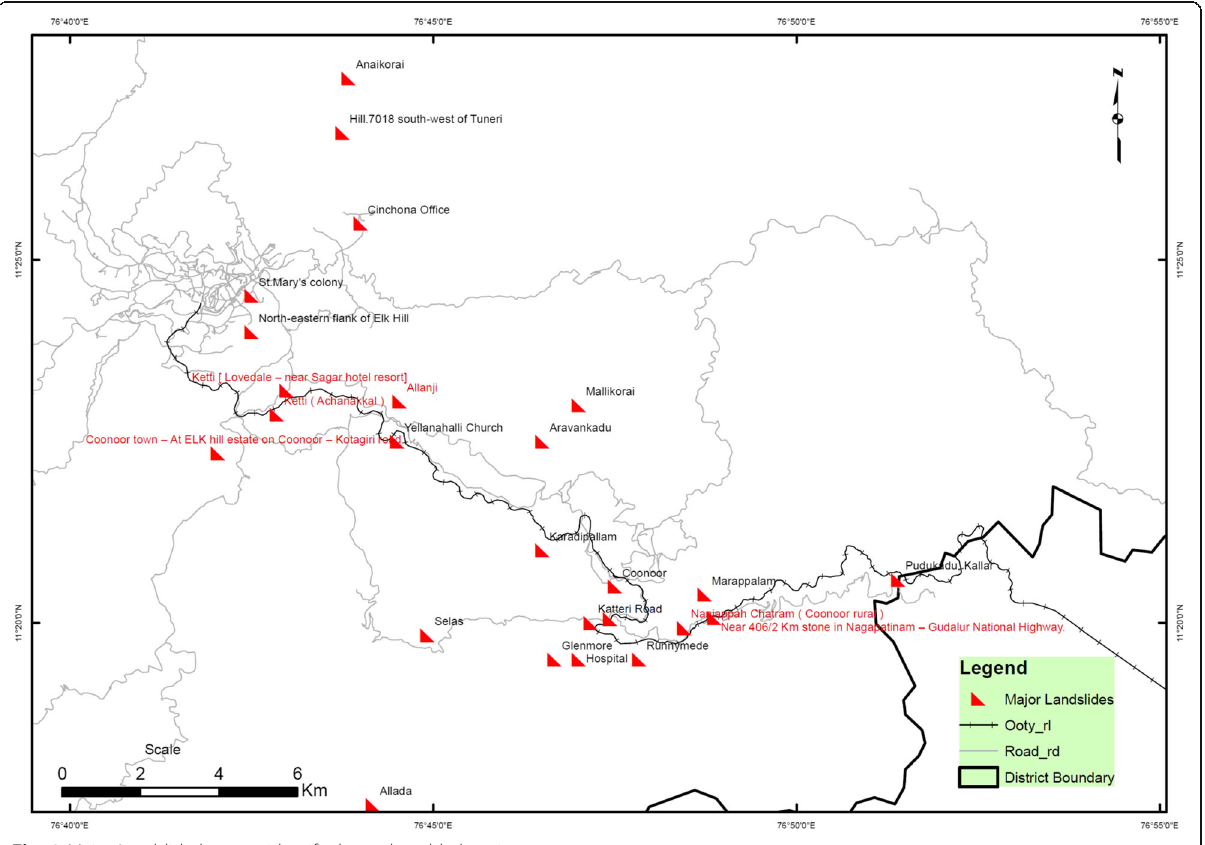
Fig. 8 Major Landslide hotspot identified as vulnerable locations